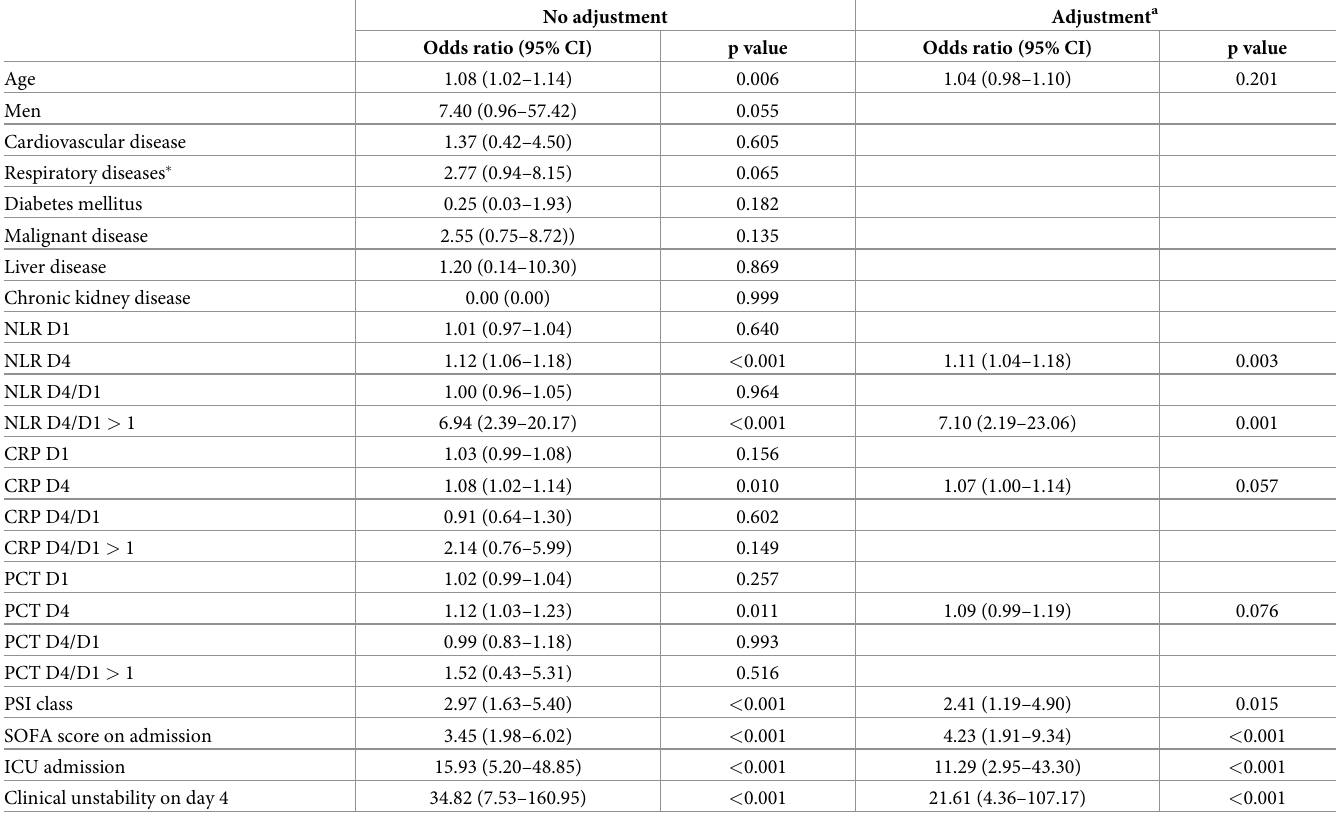
Table 4. Prognostic value of several variables for 30-day mortality.